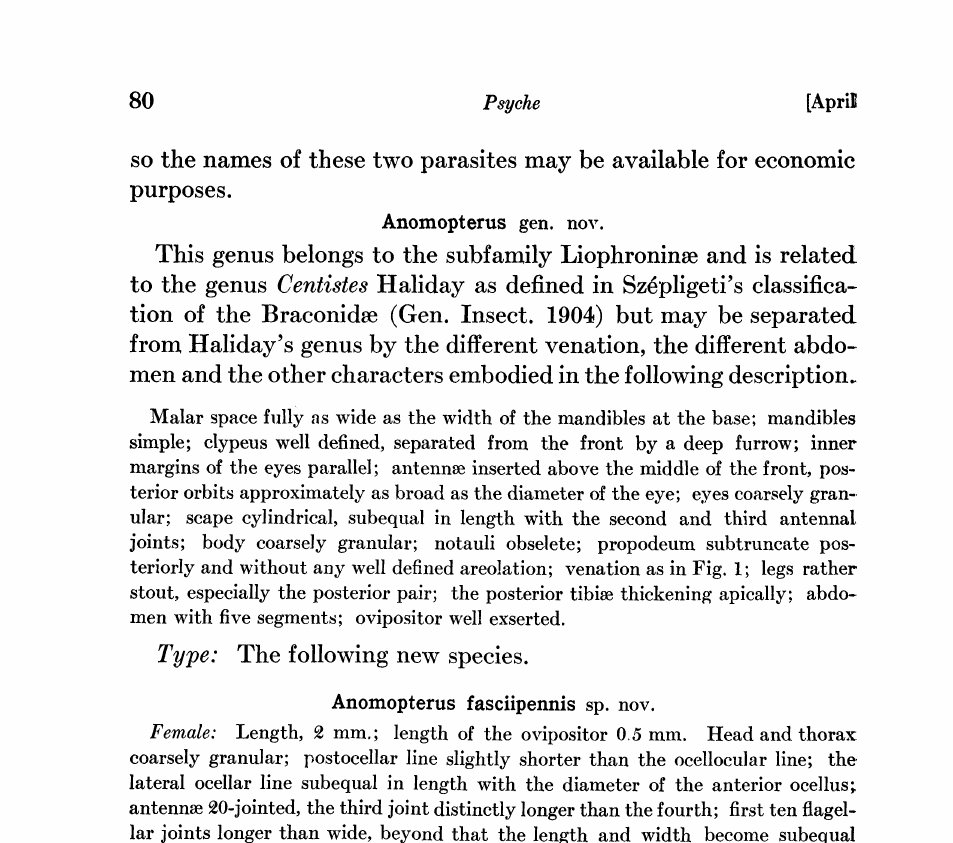
Fig. 1. Anomopterus fas.